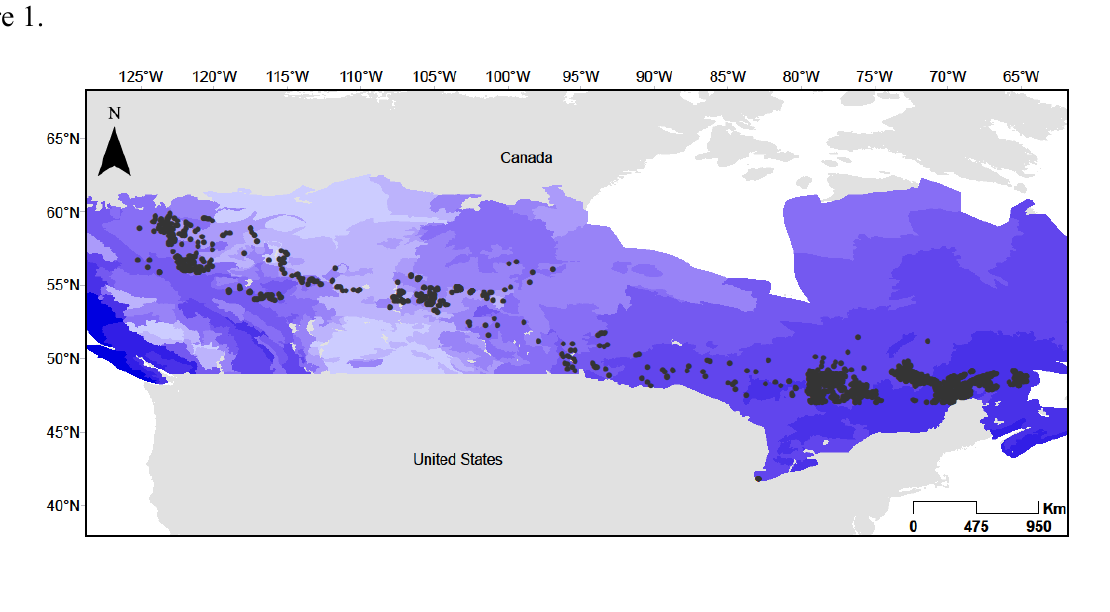
Figure 1. Map showing the distribution of plots used in this study. Plot densities are higher in the east and the area of individual plots tends to be higher in the west. The deeper the shade of blue, the higher the amount of precipitation (1981–2010 climate